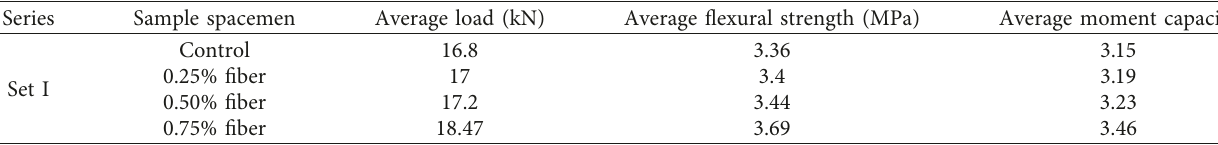
Table 4: Flexural strength of concrete 21 days test plain concrete beam samples.